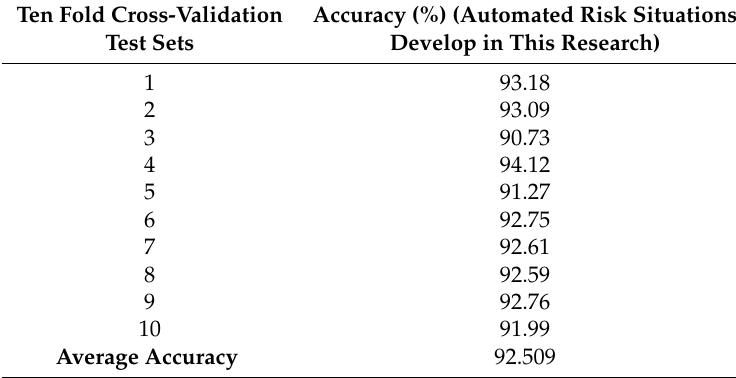
Table 12. Ten-fold validation for